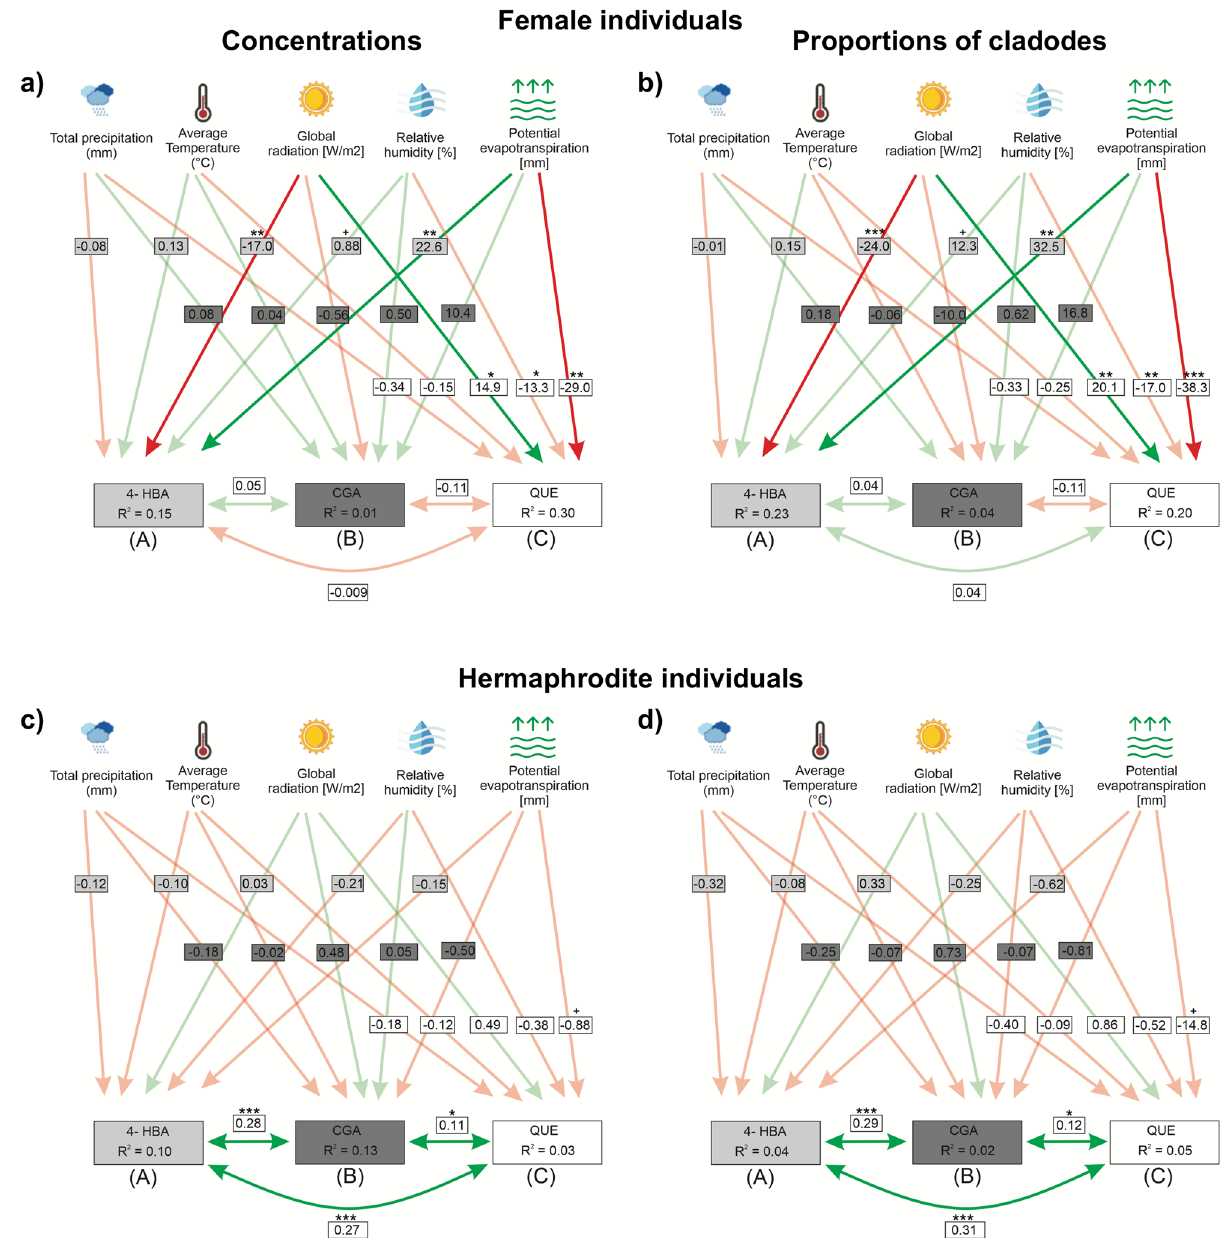
Figure 2. Structural equation model (SEM) results showing the relationship between the environmental variables and the concentration ( a ) and occurrence ( b ) of 4-hydroxybenzoic acid (4-HBA), chlorogenic acid (CGA), and quercetin (QUE) in female individuals, and the concentration ( c ) and occurrence ( d ) of these metabolites in hermaphrodite Opuntia robusta plants. For each figure, section ( A ) corresponds to the effects of the environment on the concentration of 4-HBA, ( B ) corresponds to the effects of the environment on the concentration of CGA, and ( C ) corresponds to the effects of the environment on the concentration of QUE. Green lines represent positive effects, while red lines indicate negative effects. Numbers inside the boxes on the arrows represent standardized path coefficients. R 2 for each component in the model is given inside the box. Solid lines (intense colour) represent significant pathways. Significance: + – P slightly higher than 0.05, * p < 0.05, ** p < 0.01, and *** p < 0.001. The model for female individuals was well supported by the data (Fisher’s C = 3.71; P = 0.71), but the model for hermaphrodite individuals was not (Fisher’s C = 67.34; P <